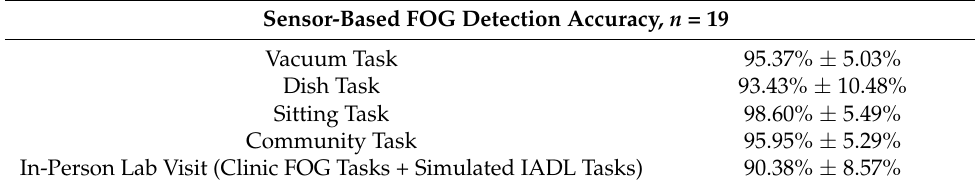
Table 2. Sensor-Based FOG Detection Accuracy, n = 19.